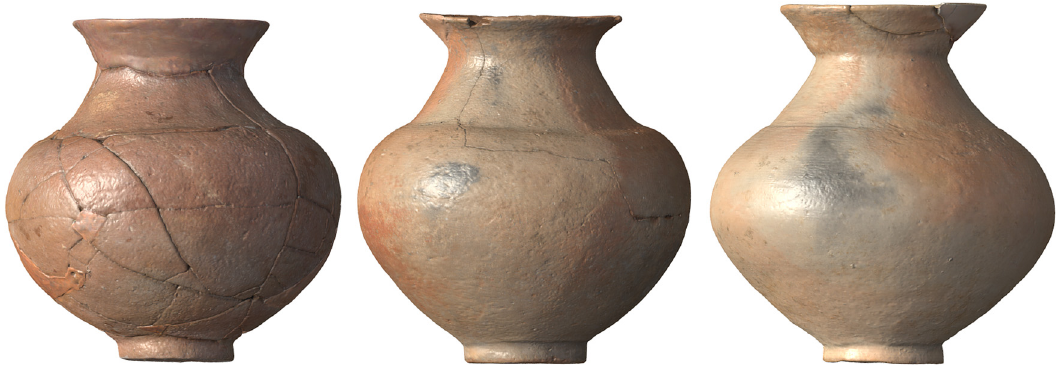
Figure 1: An example group of early Yayoi ‘ tsubo ’ globular pots from the Shimotsukiguma - tenjinmori site. The extended neck with slight outward curve is the characteristic of